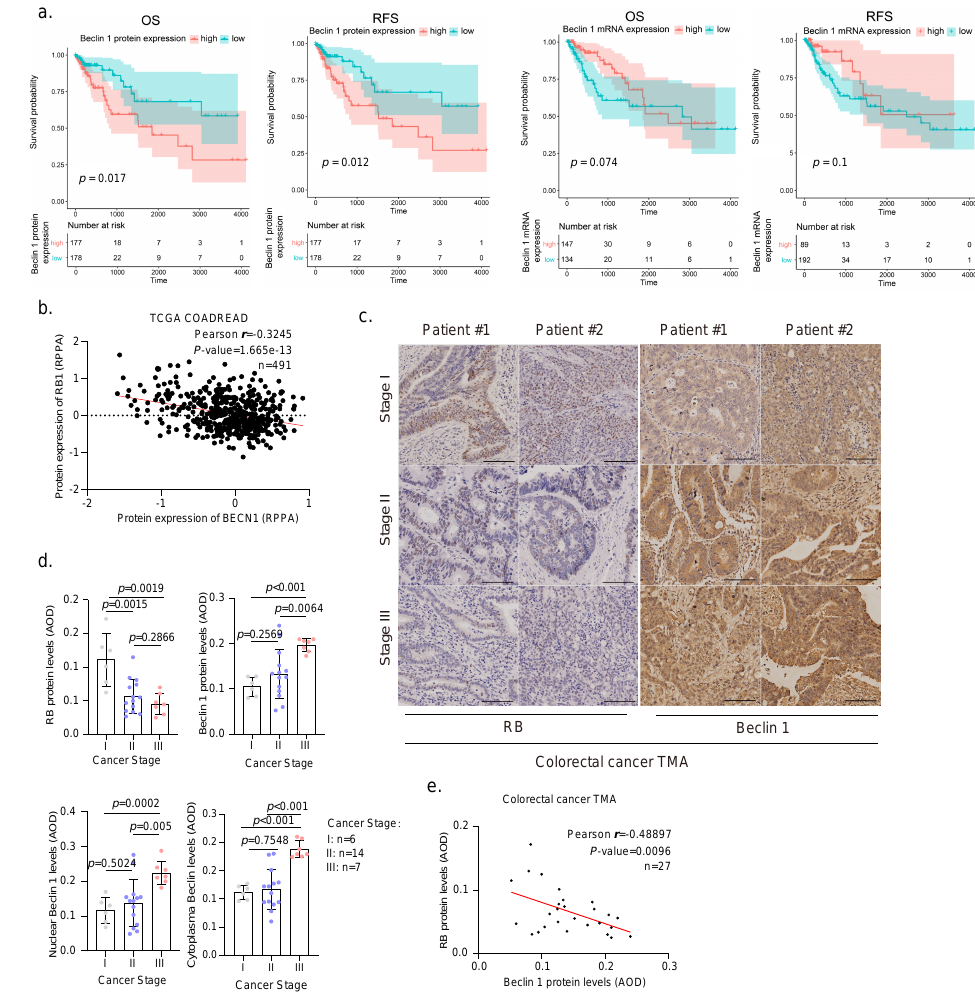
Figure 1. Clinical relevance of Beclin 1 or RB expression in human colorectal cancer specimen. ( a ) Overall survival (OS) and relapse-free survival (RFS) of colon adenocarcinoma patients were based on BECN1 mRNA expression and protein expression from TCGA-COAD dataset. Patients were stratified into high- or low-expression groups using optimal cutoff from survminer package. The blue and red areas represent the 95% confidence intervals of the high- and low-expressed groups, respectively. The tables listed below the plots show the number of patients at risk at each time point in each group. ( b ) Pearson’s correlation coefficient between the protein expressions of Beclin 1 and RB in the TCGA-COADREAD dataset was obtained from the LinkedOmics database (http://www. linkedomics.org/admin.php (accessed on 10 September 2022)). Reverse-Phase Protein Array, RPPA. ( c , d ) Human colorectal cancer tissue microarrays consisting of cancer specimens from three cancer stages (stage I, n = 6; II, n = 14; III, n = 7) were subjected to IHC staining for RB and Beclin 1, with quantitative analyses using average optical density (AOD). ( e ) Pearson’s correlation between RB and Beclin 1 in colorectal cancer patients was analyzed. Scale bar = 50